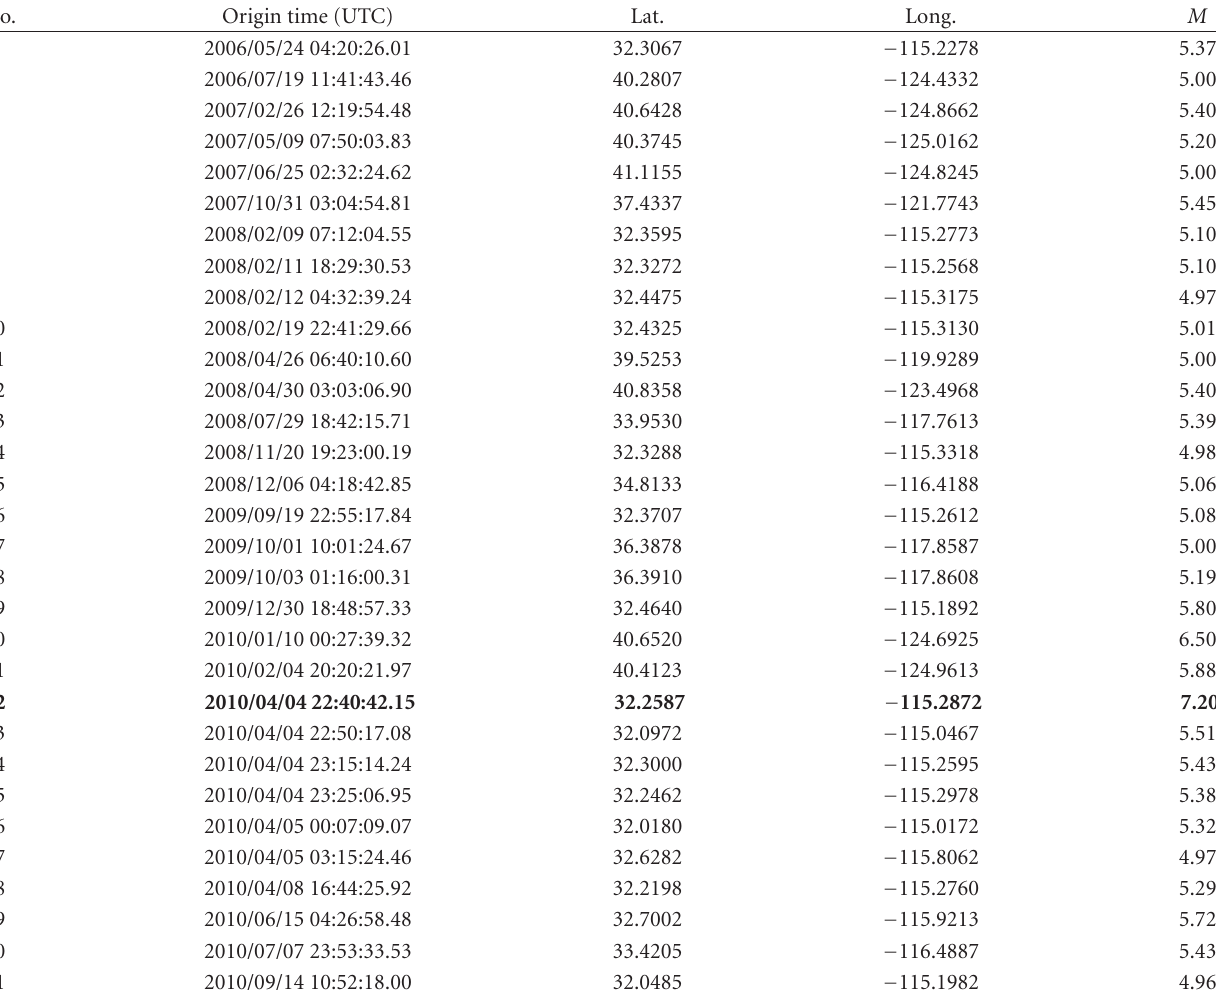
Table 1: Times of occurrence, locations, and magnitudes of the 31 earthquakes in the test region with M ≥ 4 . 95 from 1 January 2006 until 31 December 2010. The M = 7 . 2 El Mayor-Cucapah earthquake is in